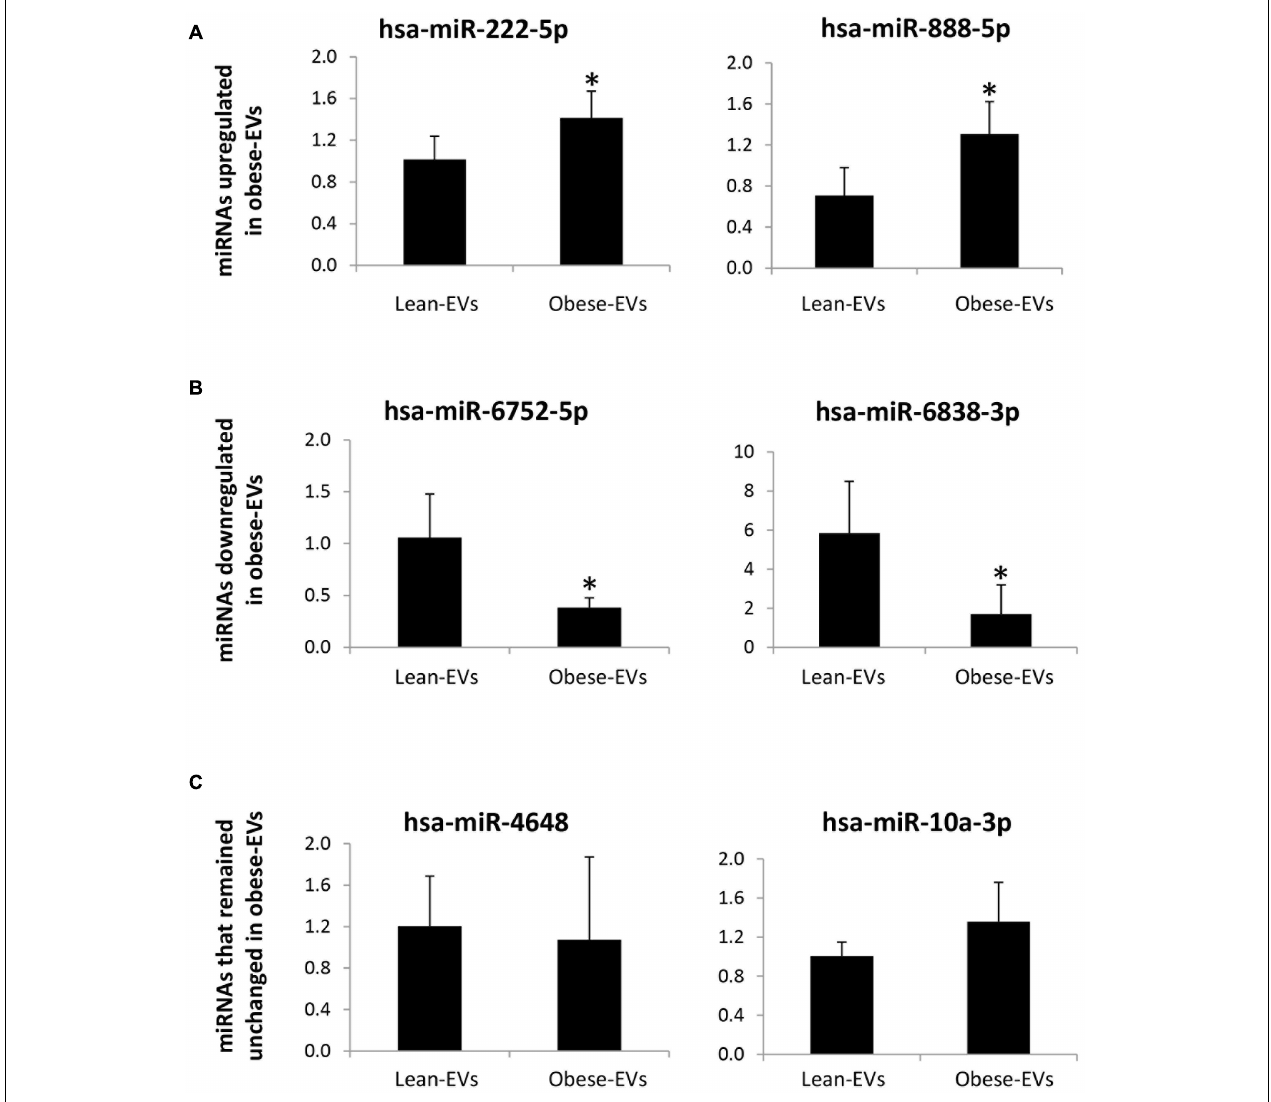
FIGURE 4 | miRNA sequencing validation. In samples treated with RNAse expression of candidate miRNAs by qPCR followed the same patterns as the original miRNA sequencing findings (without RNAse treatment). hsa-miR-222-5p and has-miR-888-5p, which were upregulated in obese-EVs vs. lean-EVs by miRNA sequencing analysis were also upregulated in obese-EVs vs. lean-EVs treated with RNAse (A) . hsa-miR-6752-5p and has-miR-6338-3p, which were downregulated in obese-EVs vs. lean-EVs by miRNA sequencing analysis were also downregulated in obese-EVs vs. lean-EVs treated with RNAse (B) . hsa-miR-4648